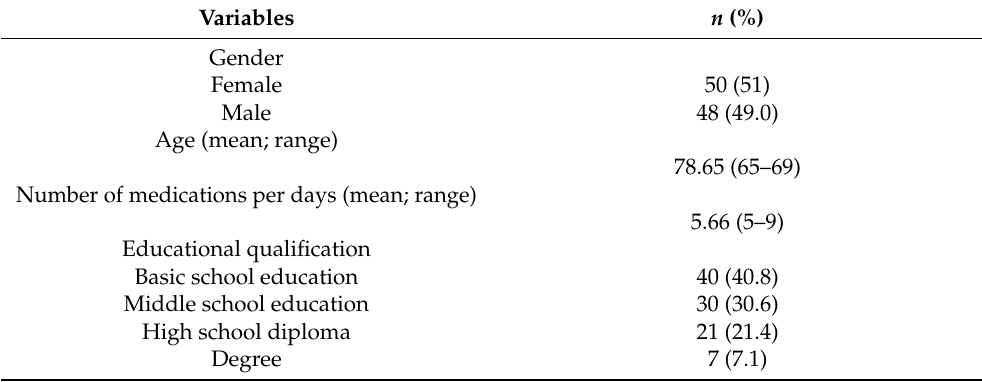
Table 1. Characteristics of